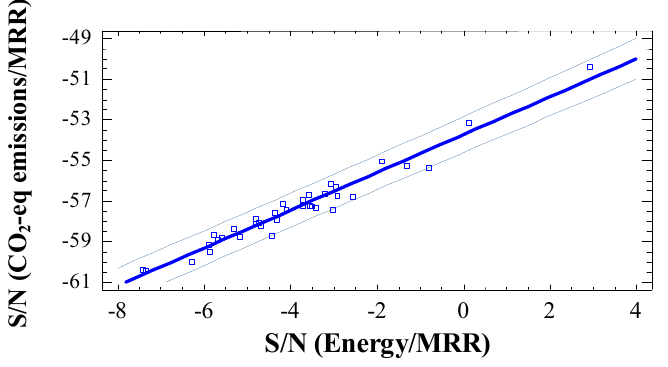
Figure 9. Fitted linear regression model.